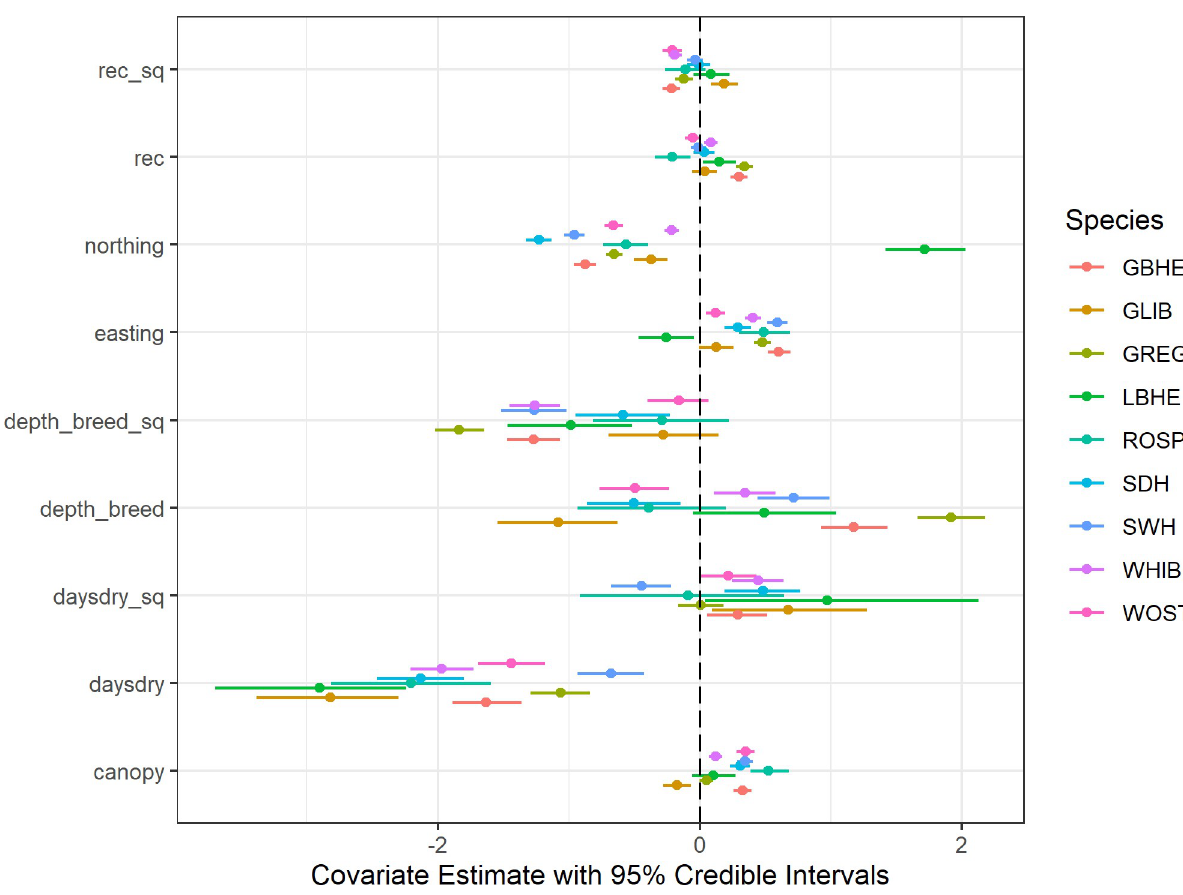
Fig 3. Covariate coefficient estimates. Covariate estimates for the site covariates (mean of the posterior and 95% posterior interval) based on SRF surveys conducted between 2000–2009 for 9 species resulting from a joint species distribution model accounting for imperfect detection. Species are: GBHE (great blue heron); GLIB (glossy ibis); GREG (great egret); LBHE (little blue heron); ROSP (roseate spoonbill); SDH (small dark herons); SWH (small white herons); WHIB (white ibis); and WOST (wood stork).